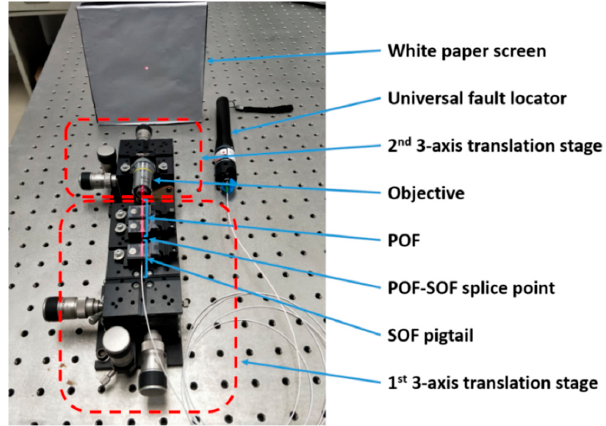
Figure 2. POF-silica optical fiber (SOF) connectorization set-up imaging method including an objective, a red-light universal fault locator, two translation stages and a white paper screen.